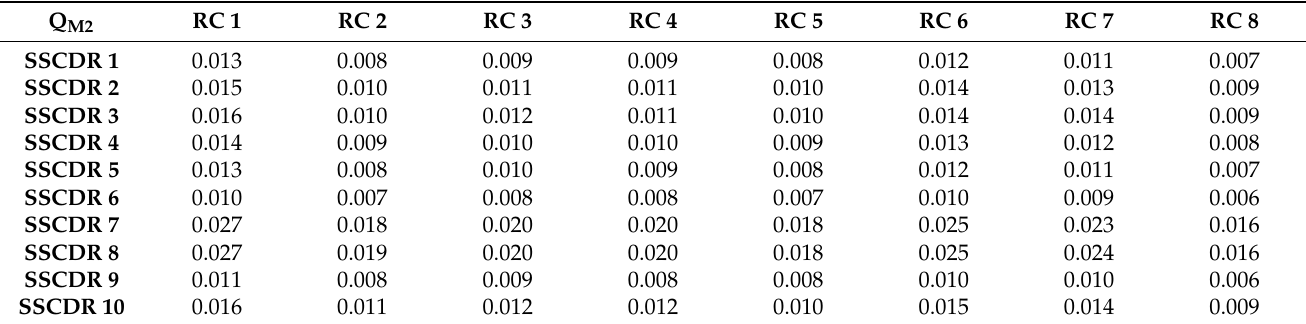
Table 8. Integrated evaluation matrix (Q M2 ) after normalized (Q M1 ).